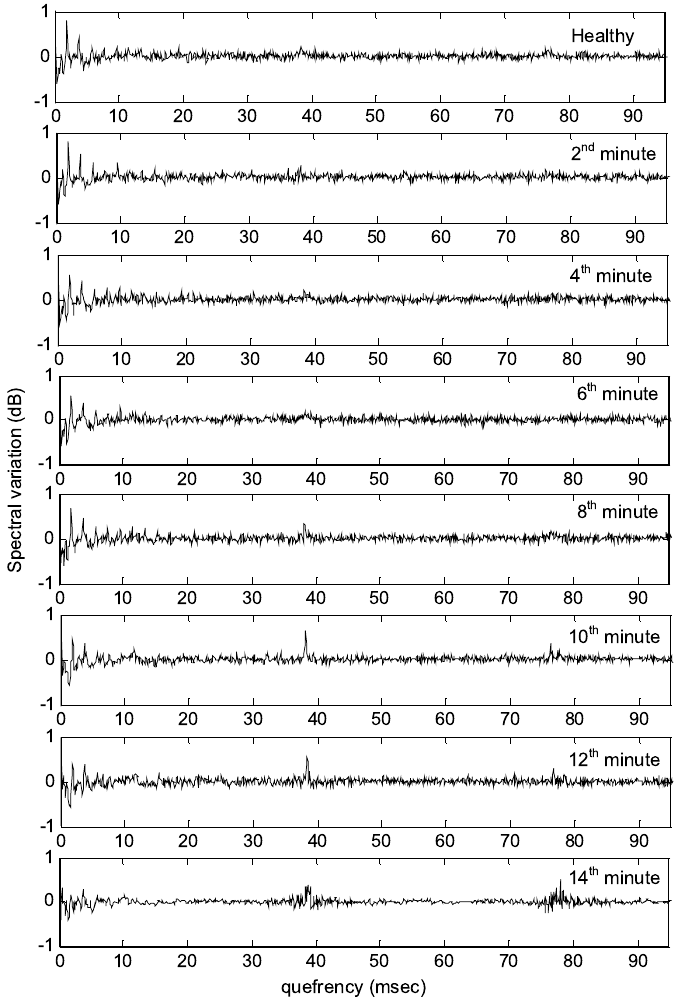
Fig. 11. Cepstra of the averaged gear vibrations monitored at two-minute intervals during the fatigue